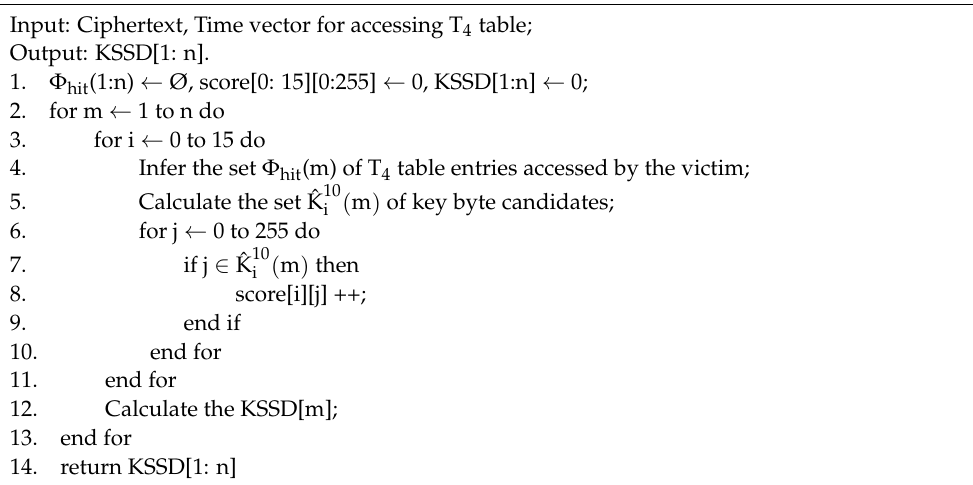
Algorithm 1 Calculating the KSSD after each